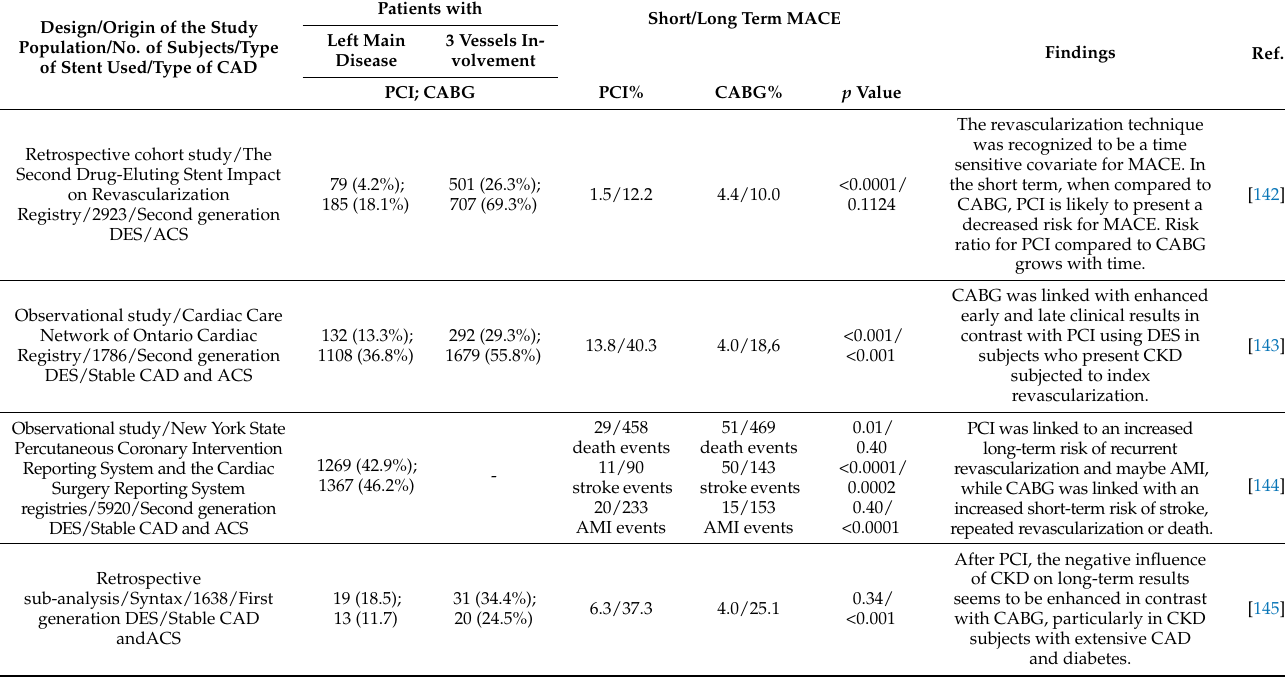
Table 3. Comparison of interventional and surgical revascularization in patients with CAD and CKD. Patients with Short/Long Term Design/Origin of the Study Population/No. of Subjects/Type of Stent Used/Type of CAD